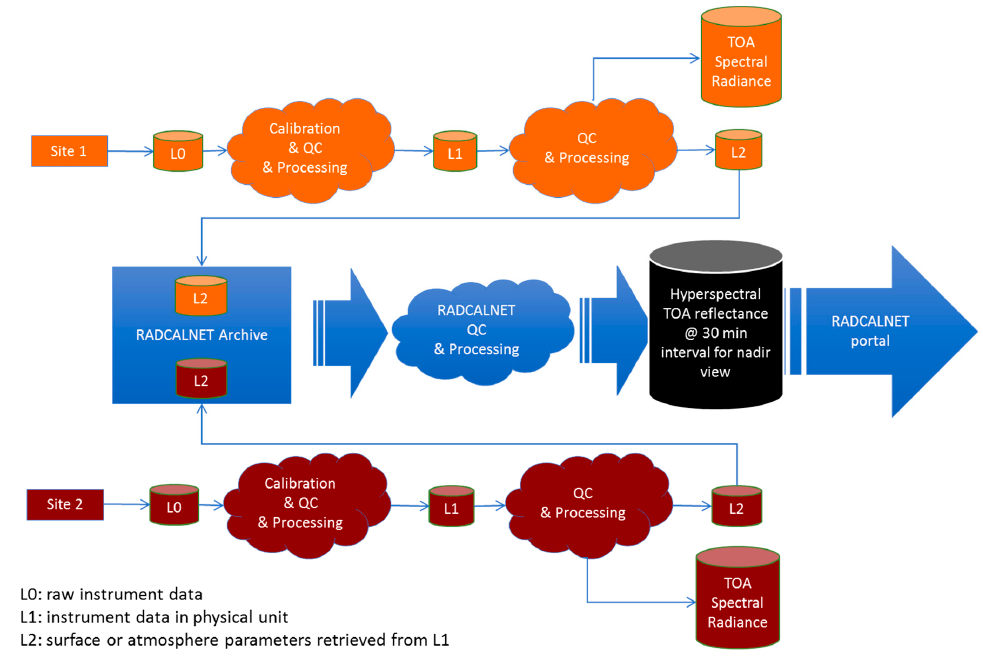
Figure 2. Diagram illustrating the processing scheme for RadCalNet based on two automated instrumented sites. TOA: top-of-atmosphere. QC: Quality